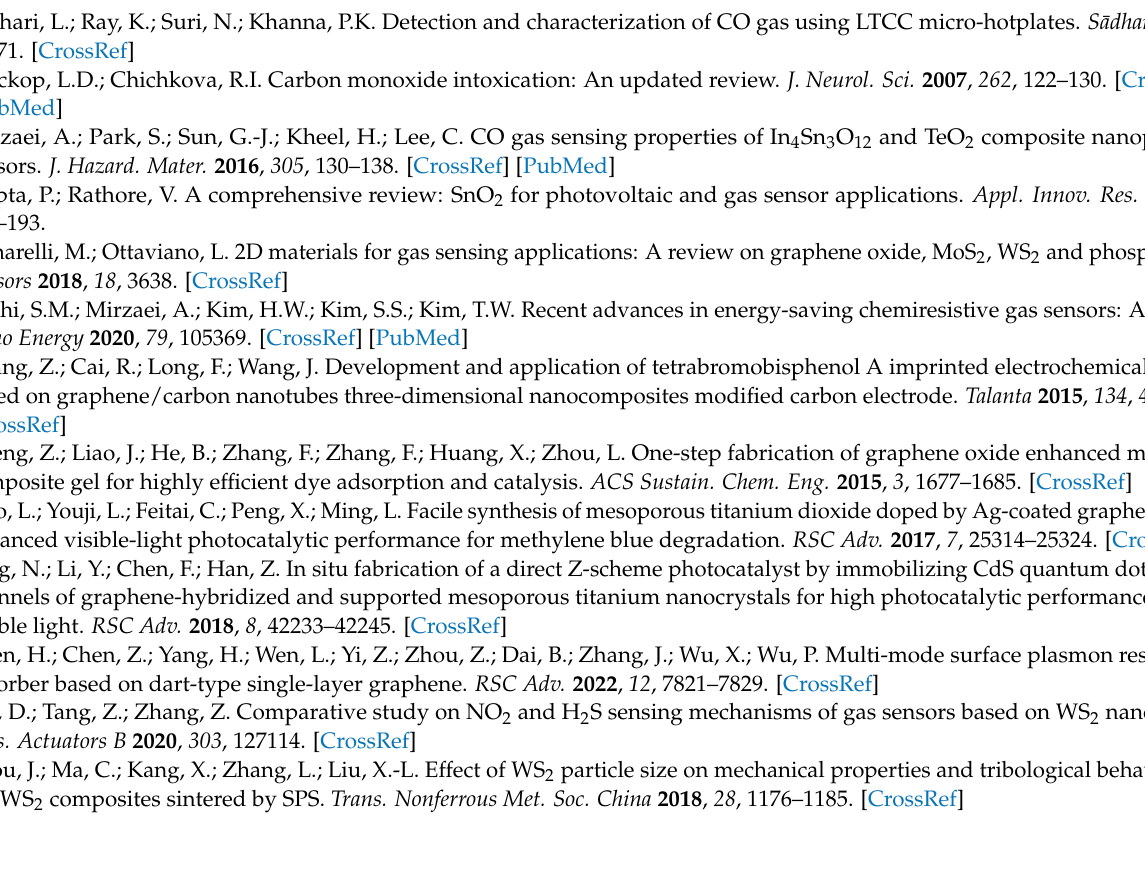
decorated SnO 2 NW, and Au-decorated 30 wt% SnO 2 –WS 2 composite gas sensors. Figure S7: Sensor temperature versus applied voltage for different gas sensors. Text S1: Supplementary explanation for Figure S7. Figure S8: (a) Repeatability (ten sequential cycles) of Au-decorated 10 wt% SnO 2 –WS 2 composite gas sensor to 50 ppm CO at 6.8 V. (b) Sensor response at different cycles. (c) Dynamic resistance curves to 50 ppm of CO for fresh sensor and those kept for 3 months at the laboratory. (d) Corresponding sensing response and (e) response times and recovery times. Figure S9: (a) Microscopic geometry of pristine WS 2 and SnO 2 –WS 2 composite gas sensors on the surface of substrate. (b) Gas sensing mechanism in p-type WS 2 and n-type SnO 2 gas sensors. Energy-band diagrams showing (c) p-n junction. Figure S10: Energy-band diagrams showing (a) Ohmic contact with p-type semiconductor ( F m > F s) and (b) Schottky contact with p-type semiconductor ( F s > F m). Figure S11: Schematic of self-heating effects in Au-decorated 10 wt% SnO 2 –WS 2 composite gas